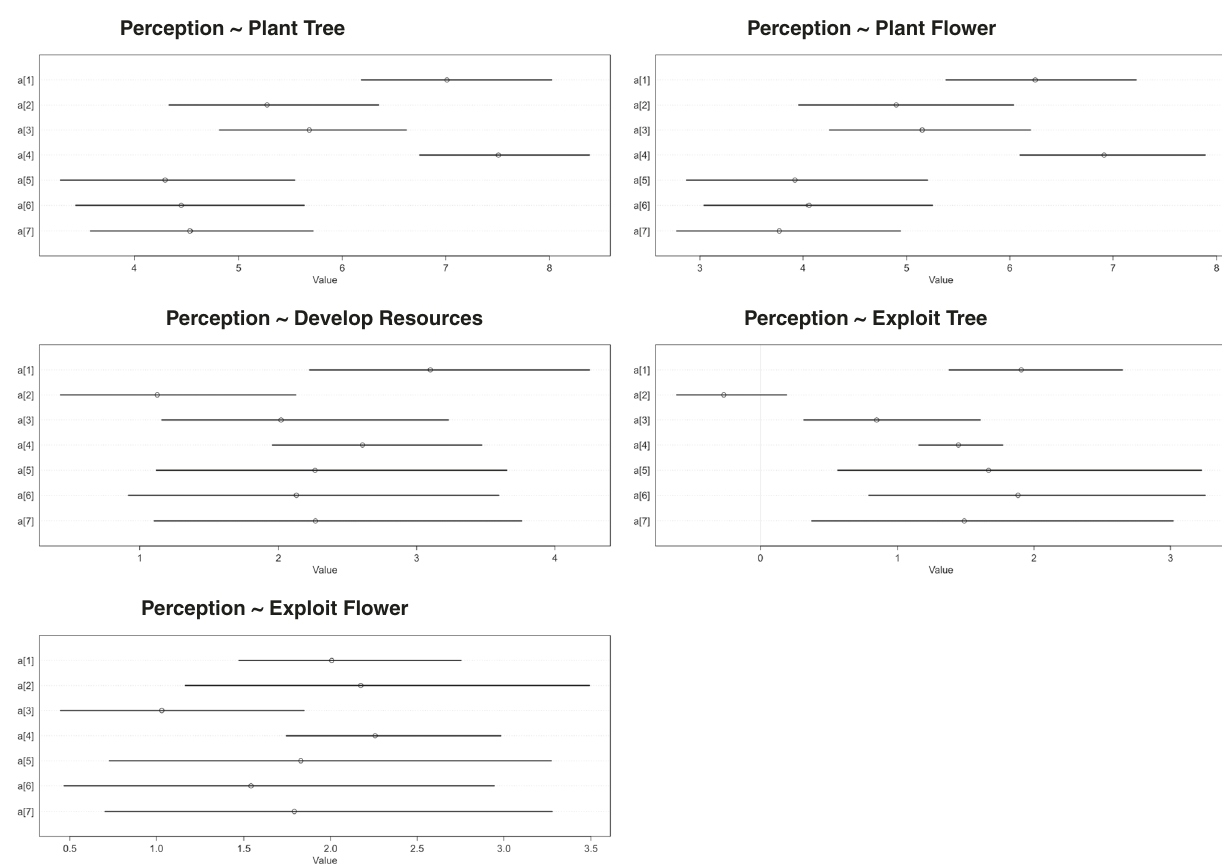
Fig. 4 Visualization of posterior distributions of the models. Note: Asian = 1, Black or African American = 2, Hispanic or Latino = 3, Caucasian = 4, Native American or American Indian = 5, Paci fi c Islander = 6, Other =